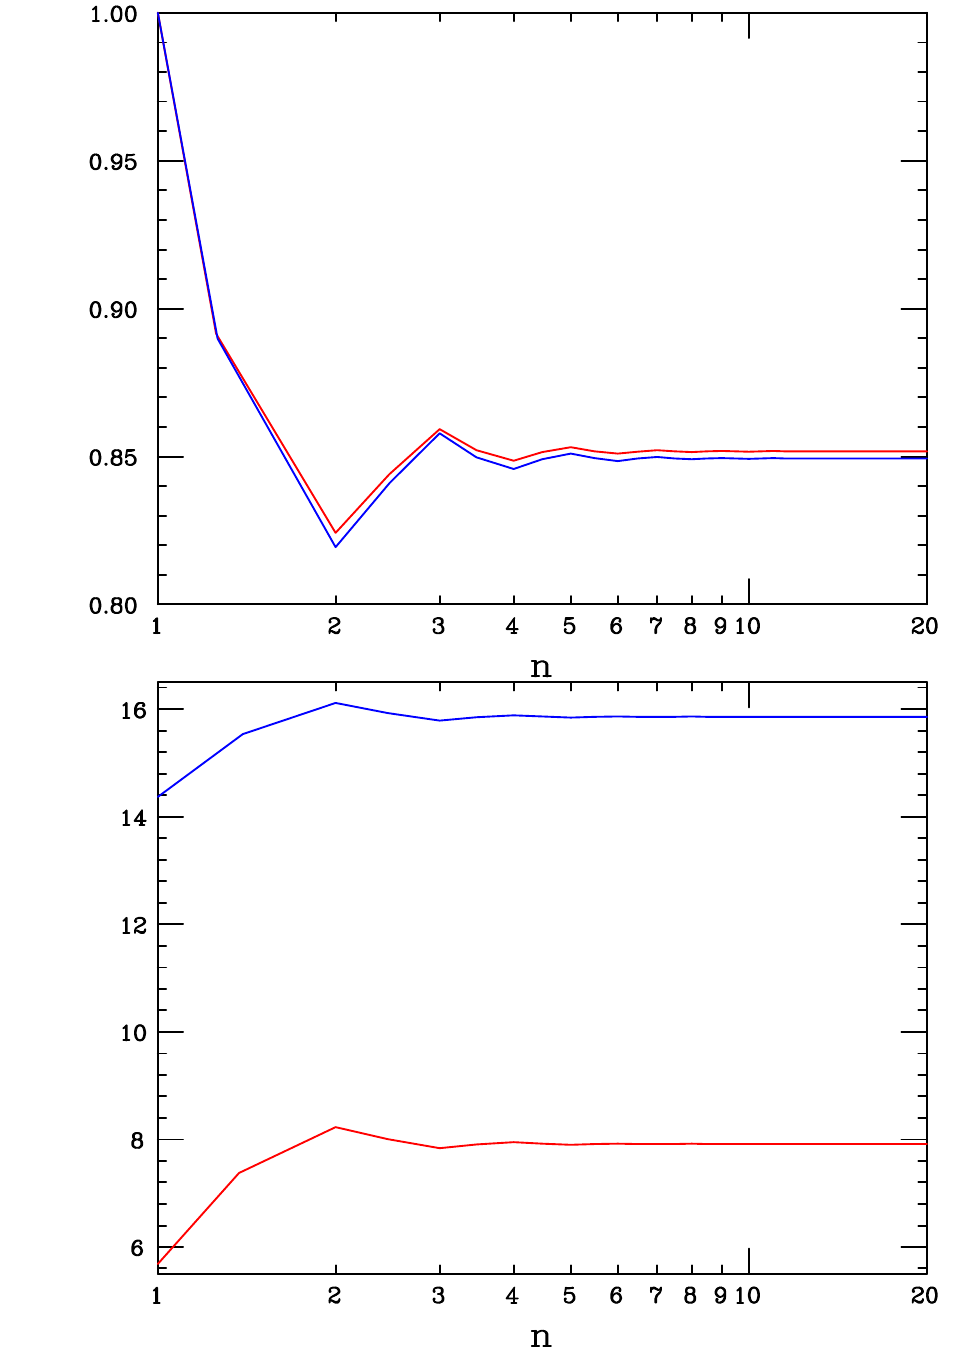
Figure 7 . Top: values of the quantity ‘Sum’ appearing in the expression for the thermal DM anni- hilation cross section as a function of the number of gauge KK tower states, n , included in the sum, as described in the text; the upper(lower) curve corresponds to the case of BM1(BM2). Bottom: value of the quantity b , as de(cid:12)ned in the text, for BM1 (upper curve) and for BM2 (lower curve).